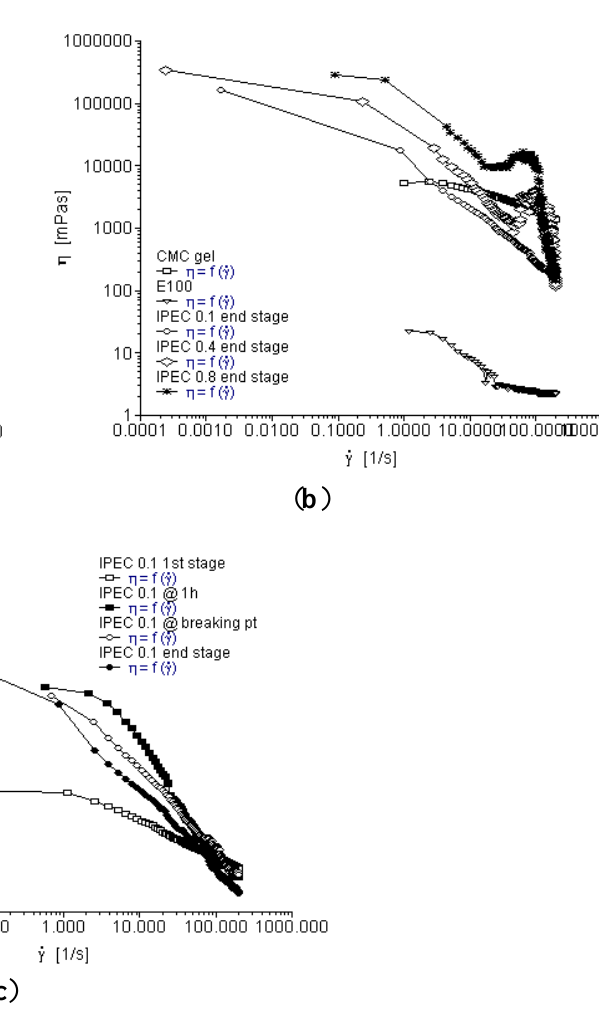
Figure 1. Viscosity as a function of shear rate for ( a ) the native polymers and interpolyelectrolyte complex (IPEC) at the first stage (sampling point I) of synthesis; ( b ) the native polymers and IPEC at the end stage (sampling point IV) of synthesis; and ( c ) IPEC at the 4 sampling points of the synthesis using 0.1 N acetic